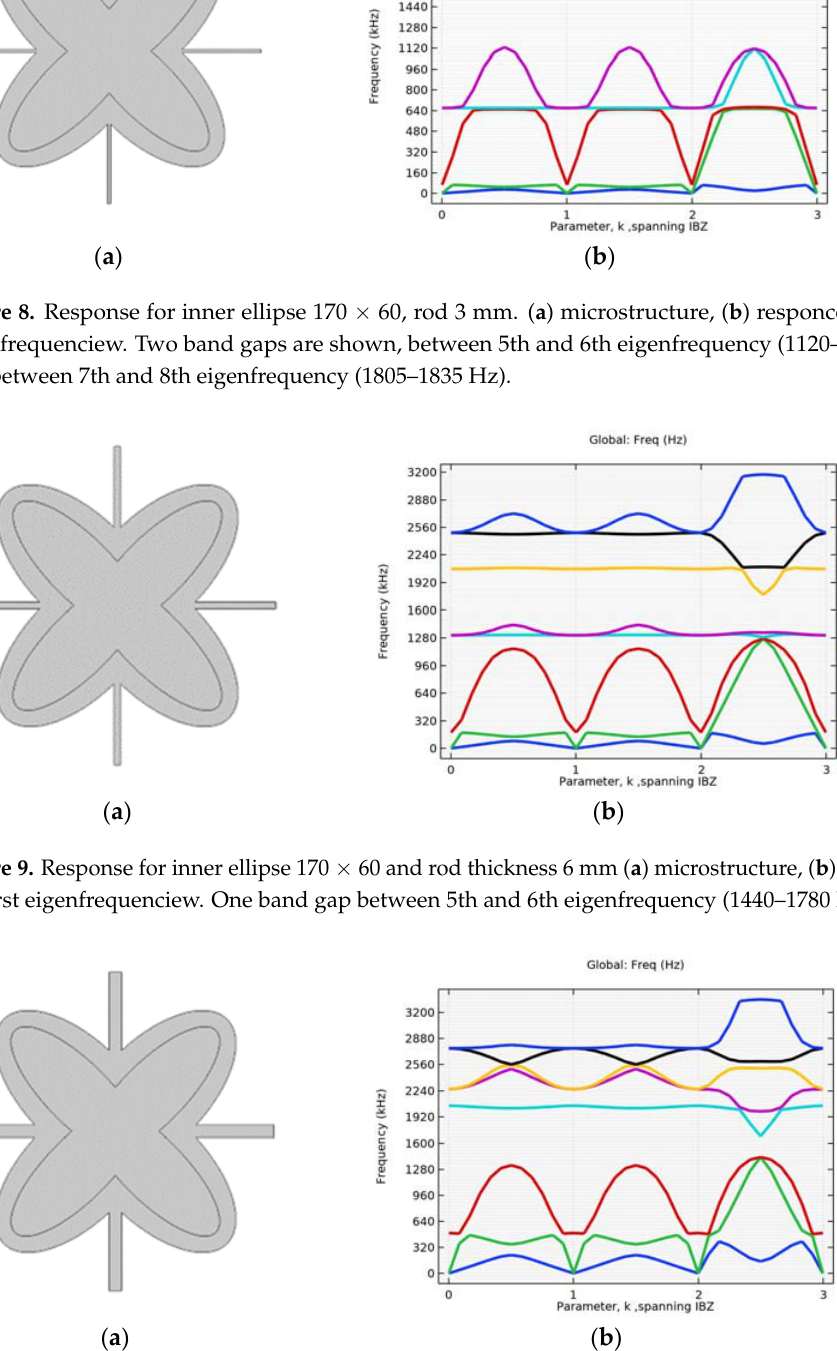
Figure 10. Response for inner ellipse 170 × 60 and rod thickness 12 mm. (a) microstructure, (b) re- sponce for first eigenfrequenciew. One band gap exists between 3rd and 4th eigenfrequency (1420– 1680 Hz).